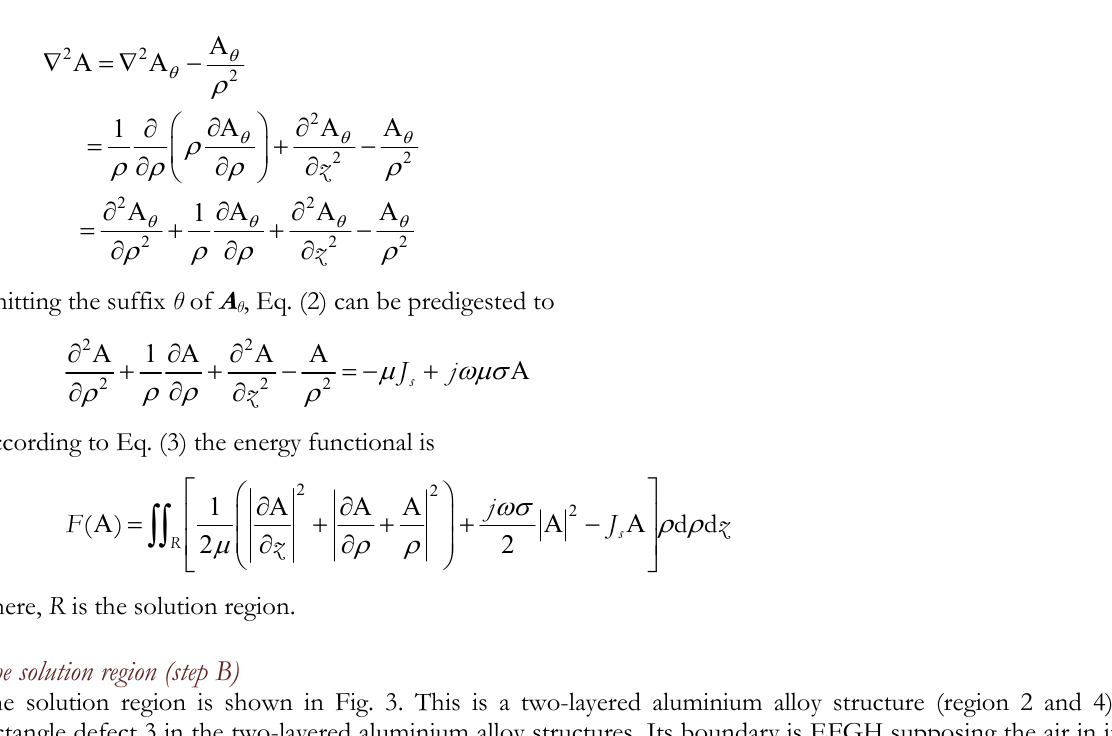
Figure 2: The cylindrical coordinates and triangle unit